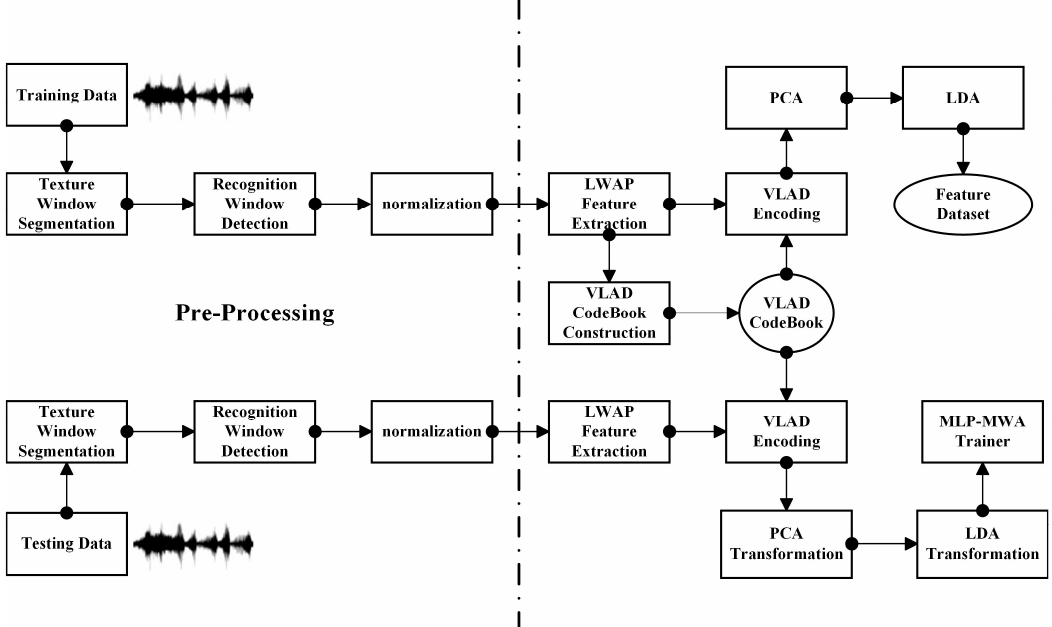
Figure 3. Passive sonar classifier flow proposed by Qiao et al.